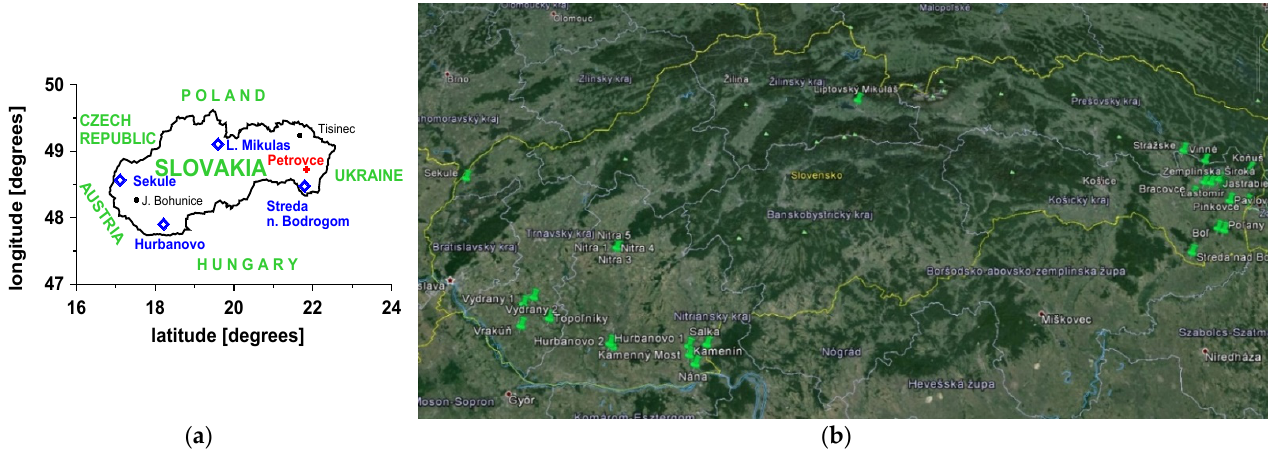
Figure 2. ( a ) Scheme of Slovakia (49,000 km 2 )—the position of four selected IH SAS stations (blue points), position of the lysimetric station (Petrovce nad Laborcom (red point)), and stations for measuring temperature at great depths up to 10 m at Tisinec and Jasovsk é Bohunice (black points). ( b ) Location of the 35 probes throughout Slovakia equipped with data teletransmission (2012–2020). See Supplementary